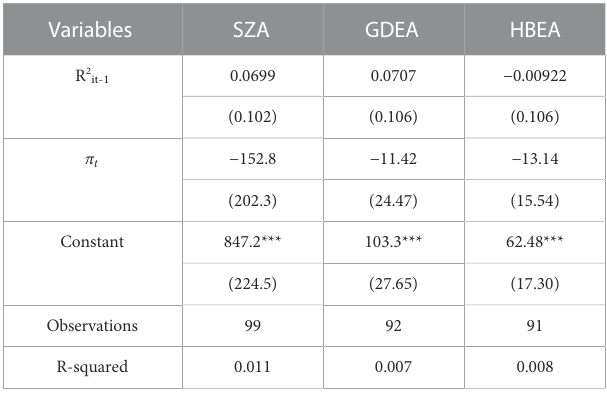
TABLE 6 Regression results of squared carbon price growth rate and in fl ation